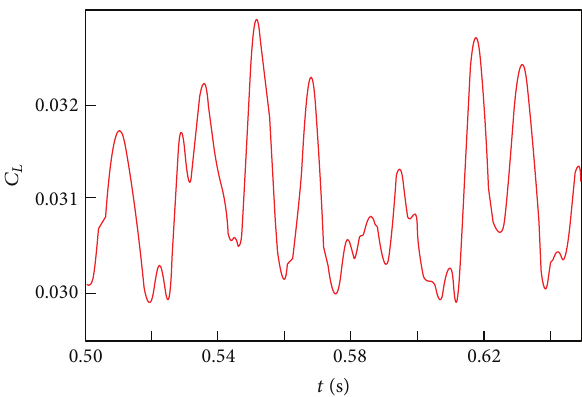
Figure 5: Lift coefficient as a function of time for the unswept wing at 𝑀 ∞ = 0.860 , 𝛼 = − 0.6 deg, Re = 5.2 × 10 6 .